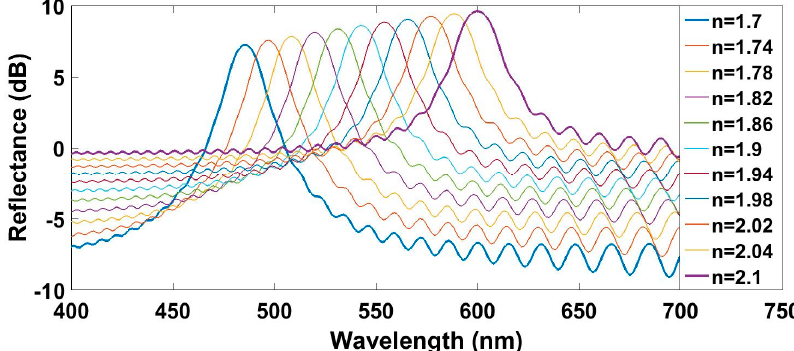
Figure 5. Simulated reflected spectra for different refractive indices with a fixed thickness of 70 nm.